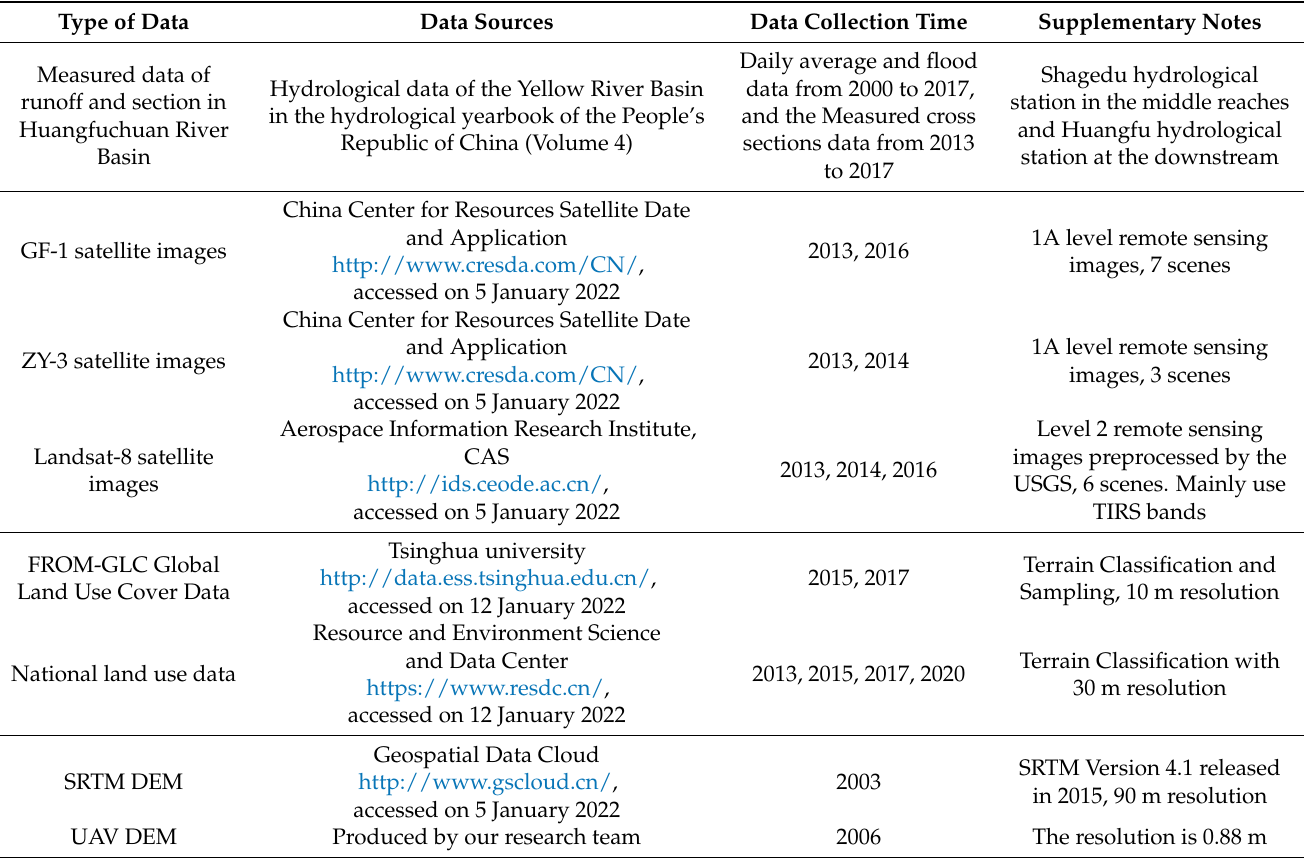
Table 1. Summary of the data used in the